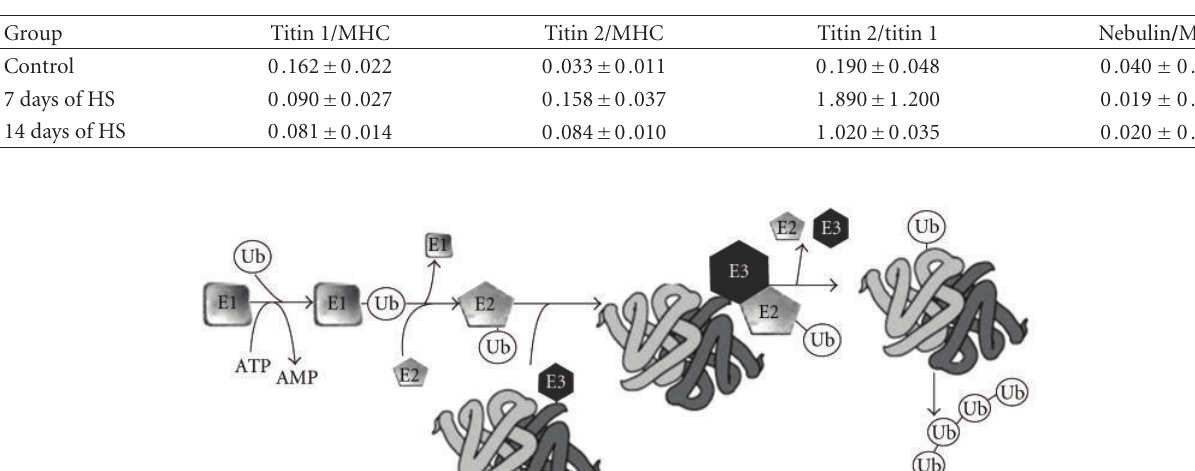
Table 1: Changes of titin and nebulin quantity in rat soleus under disuse [7].